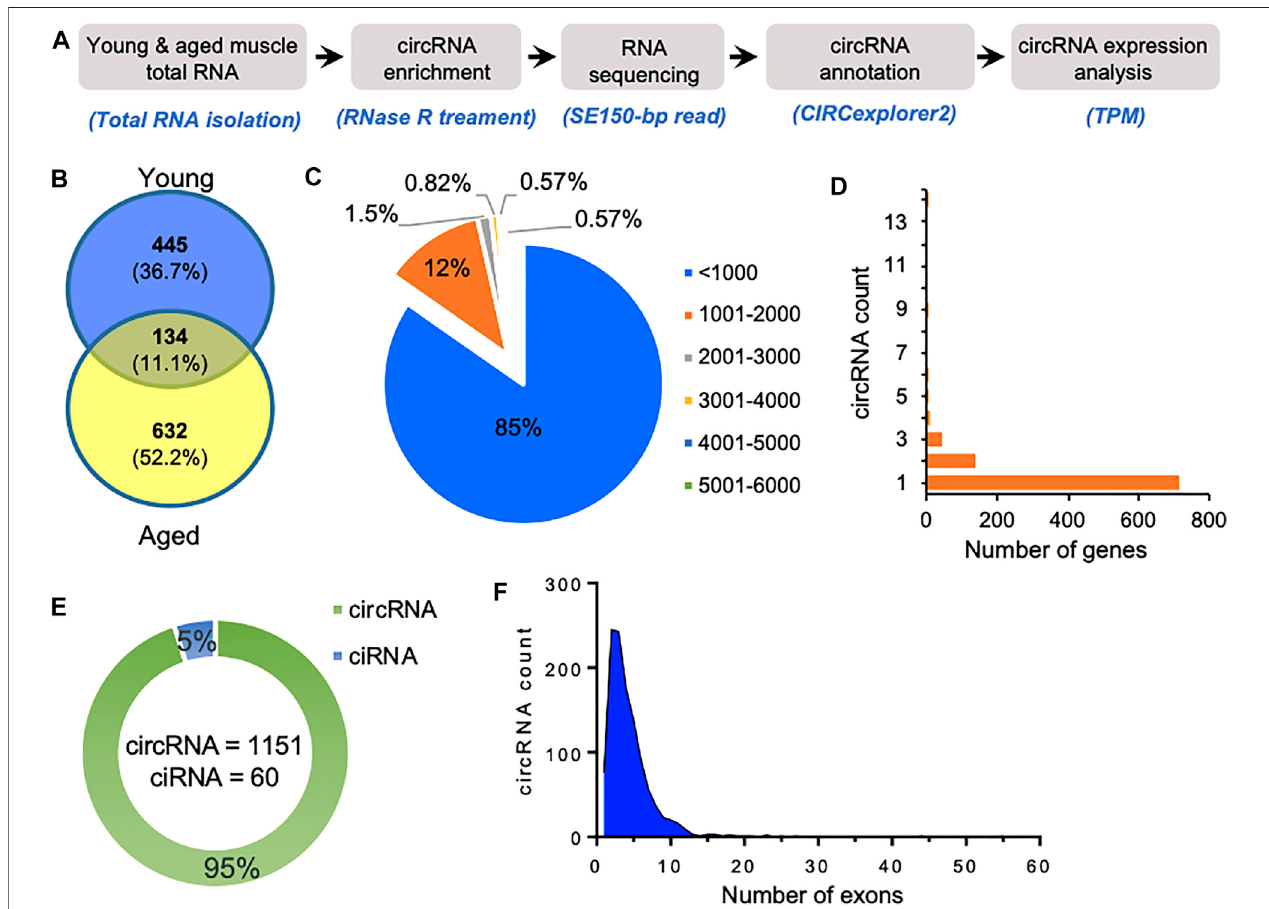
FIGURE1| CharacteristicsofcircRNAsexpressedinagingmiceskeletalmuscle. (A) .Theexperimental designandannotationofcircRNAsusingCIRCexplorer2in mousegastrocnemiusmuscle. (B) .VenndiagramshowingthenumberofcircRNAsexpressedinyoungandagedgastrocnemiusmuscleidenti fi edusingCIRCexplorer2. (C) . Percentage distribution of length of circRNAs in mouse skeletal muscle. (D) . Number of genes corresponding to the number of circRNAs generated by them. (E) . Number of exonic circRNA and intronic ciRNAs expressed in mouse skeletal muscle. (F) . Distribution of the number of exons in the exonic circRNAs expressed in gastrocnemius muscle detected with